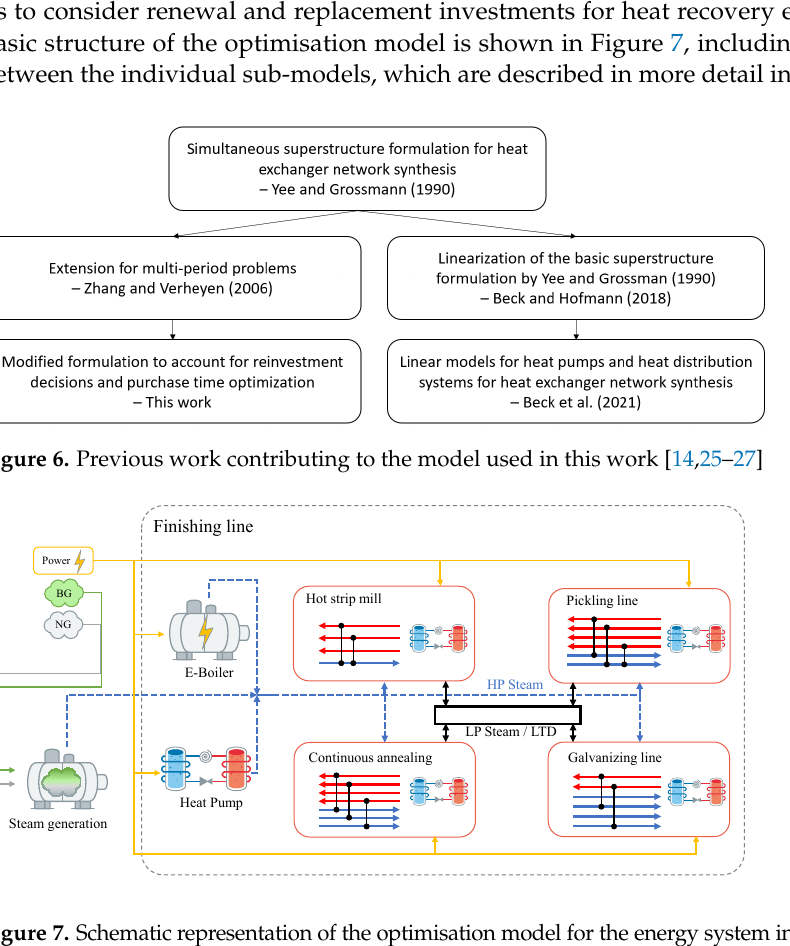
Figure 7. Schematic representation of the optimisation model for the energy system in the finishing